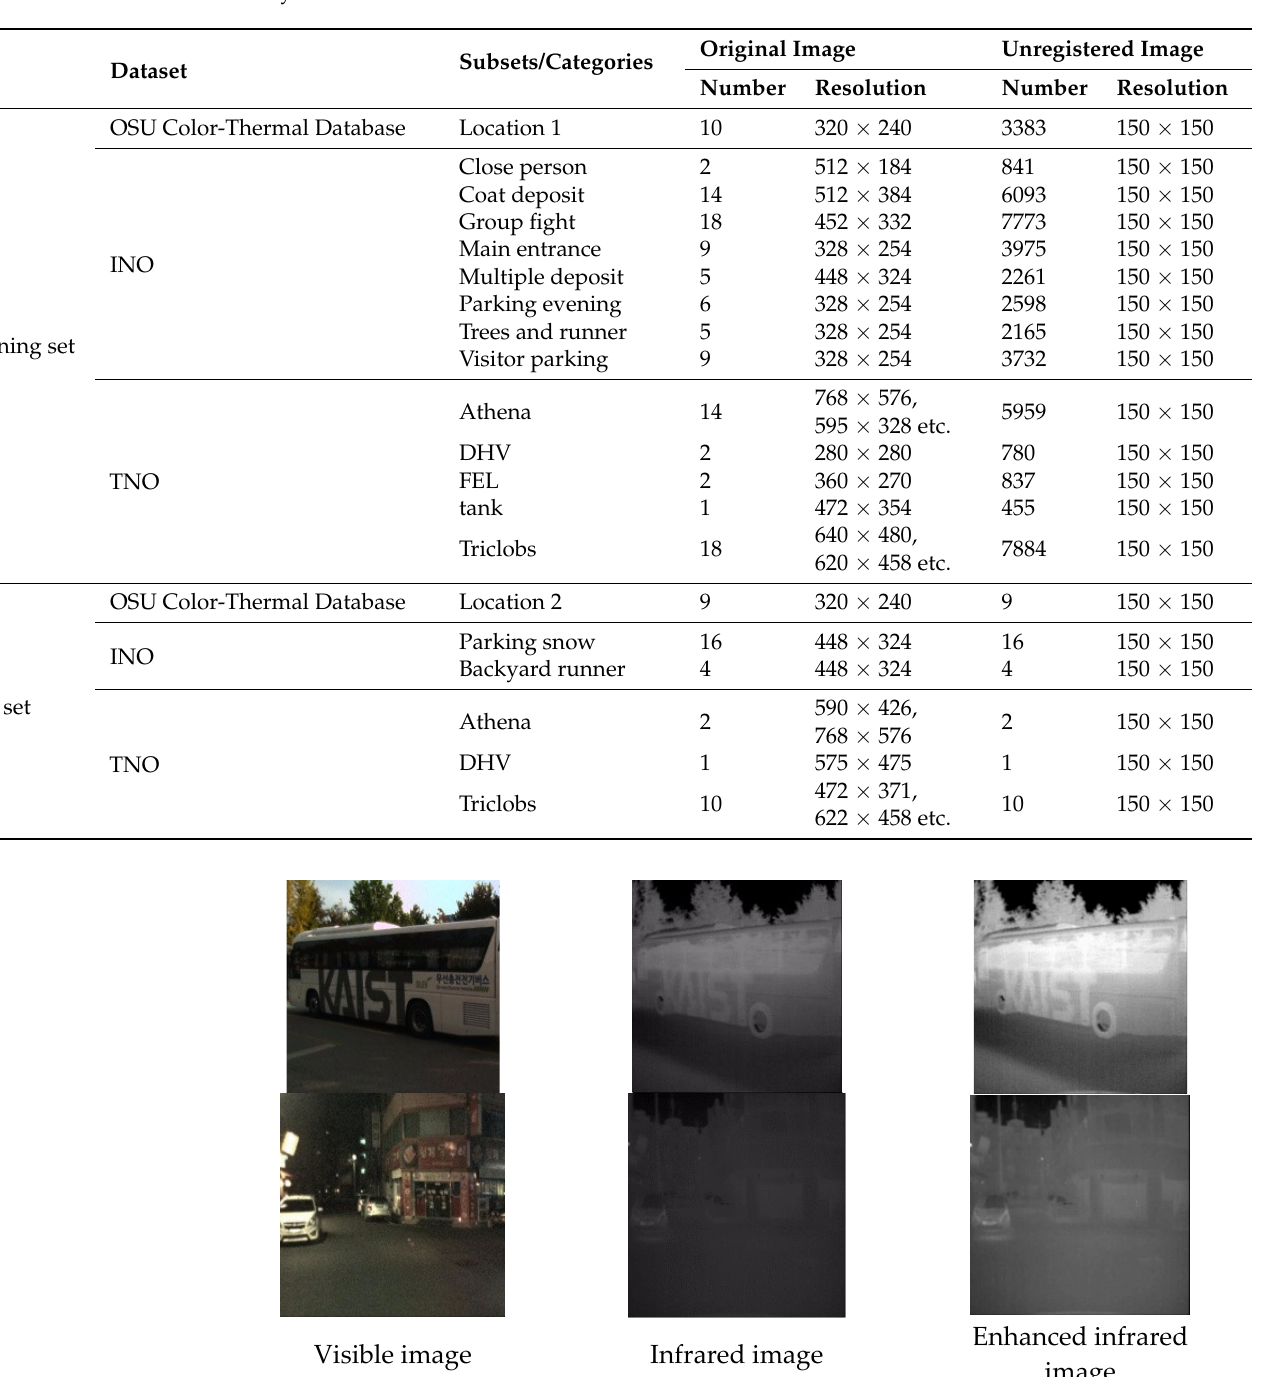
Table 2. Comparative information of the original dataset and the synthetic benchmark dataset. The source image column indicates the number and resolution of images used in different subsets or categories in the source dataset (OSU Color-Thermal Database, INO, and TNO). The unregistered image column indicates the number and resolution of images in different subsets or classes in the synthetic benchmark dataset.